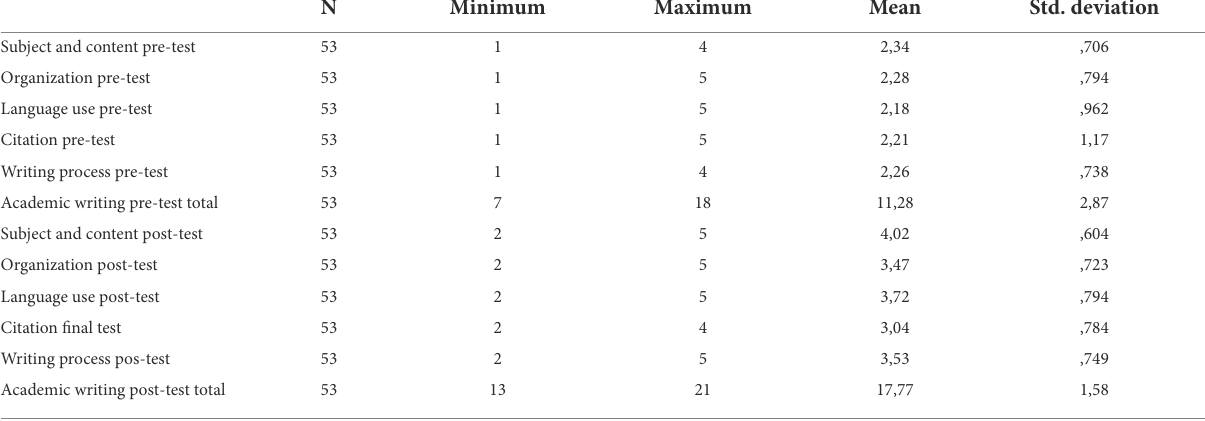
TABLE 5 Descriptive statistics for academic writing pre-test and post-test measures.